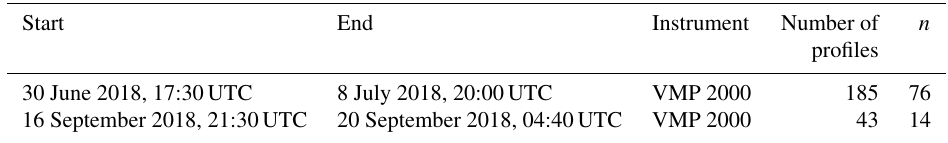
Table 1. Overview of ocean microstructure measurements. The number of profiles used in analyses is n , after batch-averaging repeat profiles in the process stations. Start End Instrument